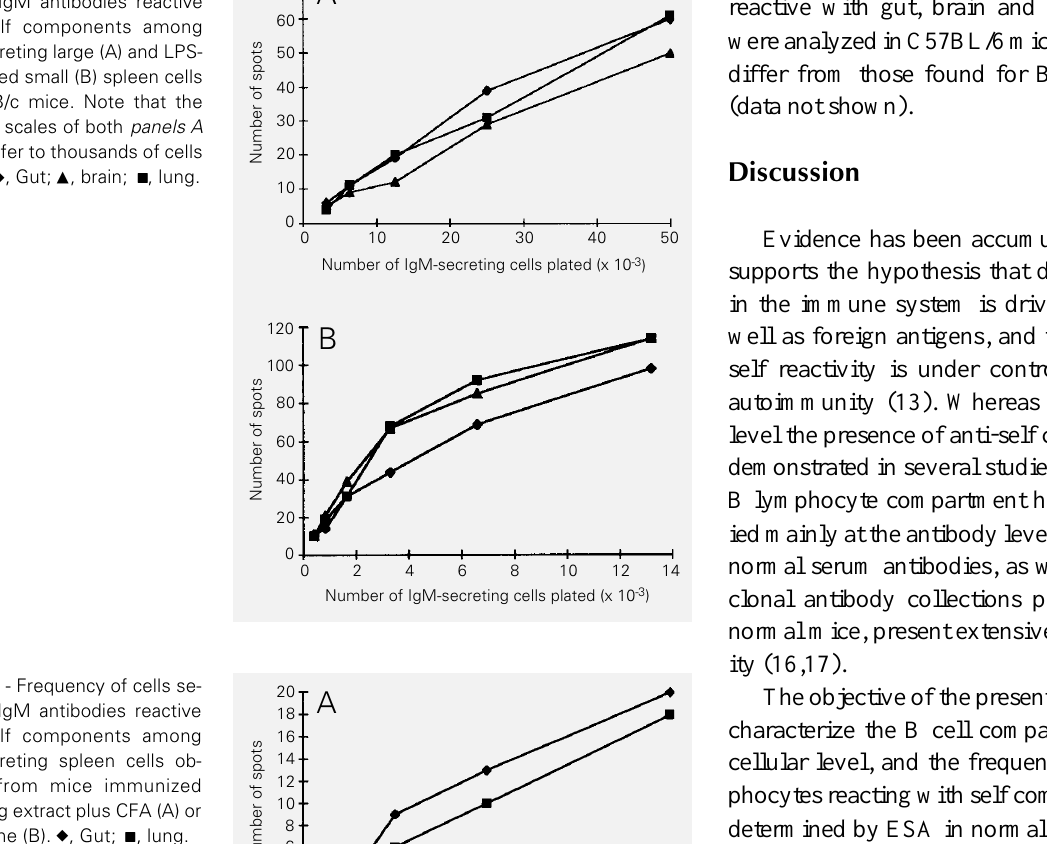
Figure 2 - Frequency of cells se- creting IgM antibodies reactive with self components among IgM-secreting large (A) and LPS- stimulated small (B) spleen cells of BALB/c mice. Note that the ordinate scales of both panels A and B refer to thousands of cells plated. ¢ , Gut; £ , brain; (cid:224) , lung.